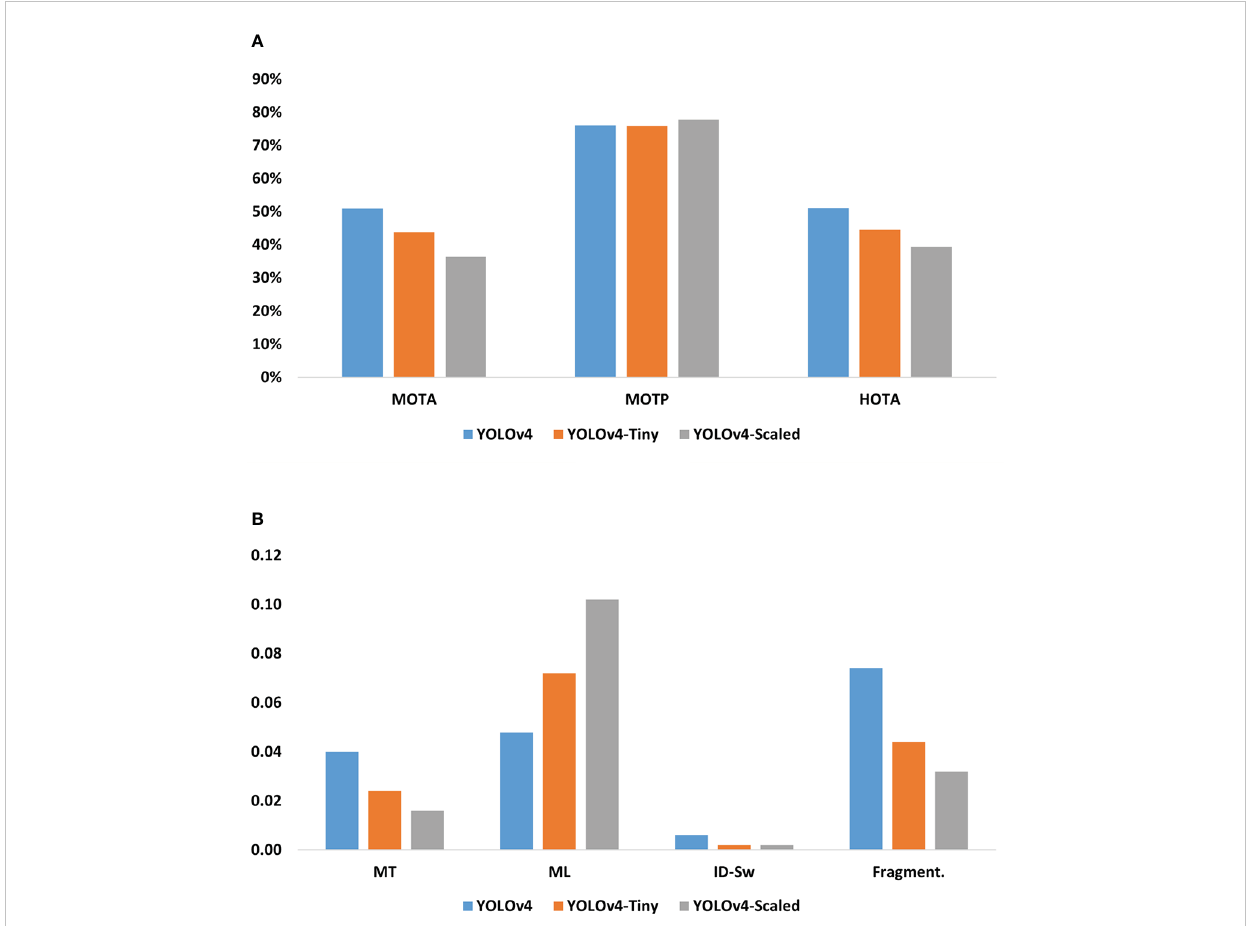
FIGURE 4 Tracking performances associated with the detectors. (A) Percentage values for MOTA, MOTP, and HOTA, (B) MT, ML, ID-Sw, and Fragmentation numbers averaged over the test